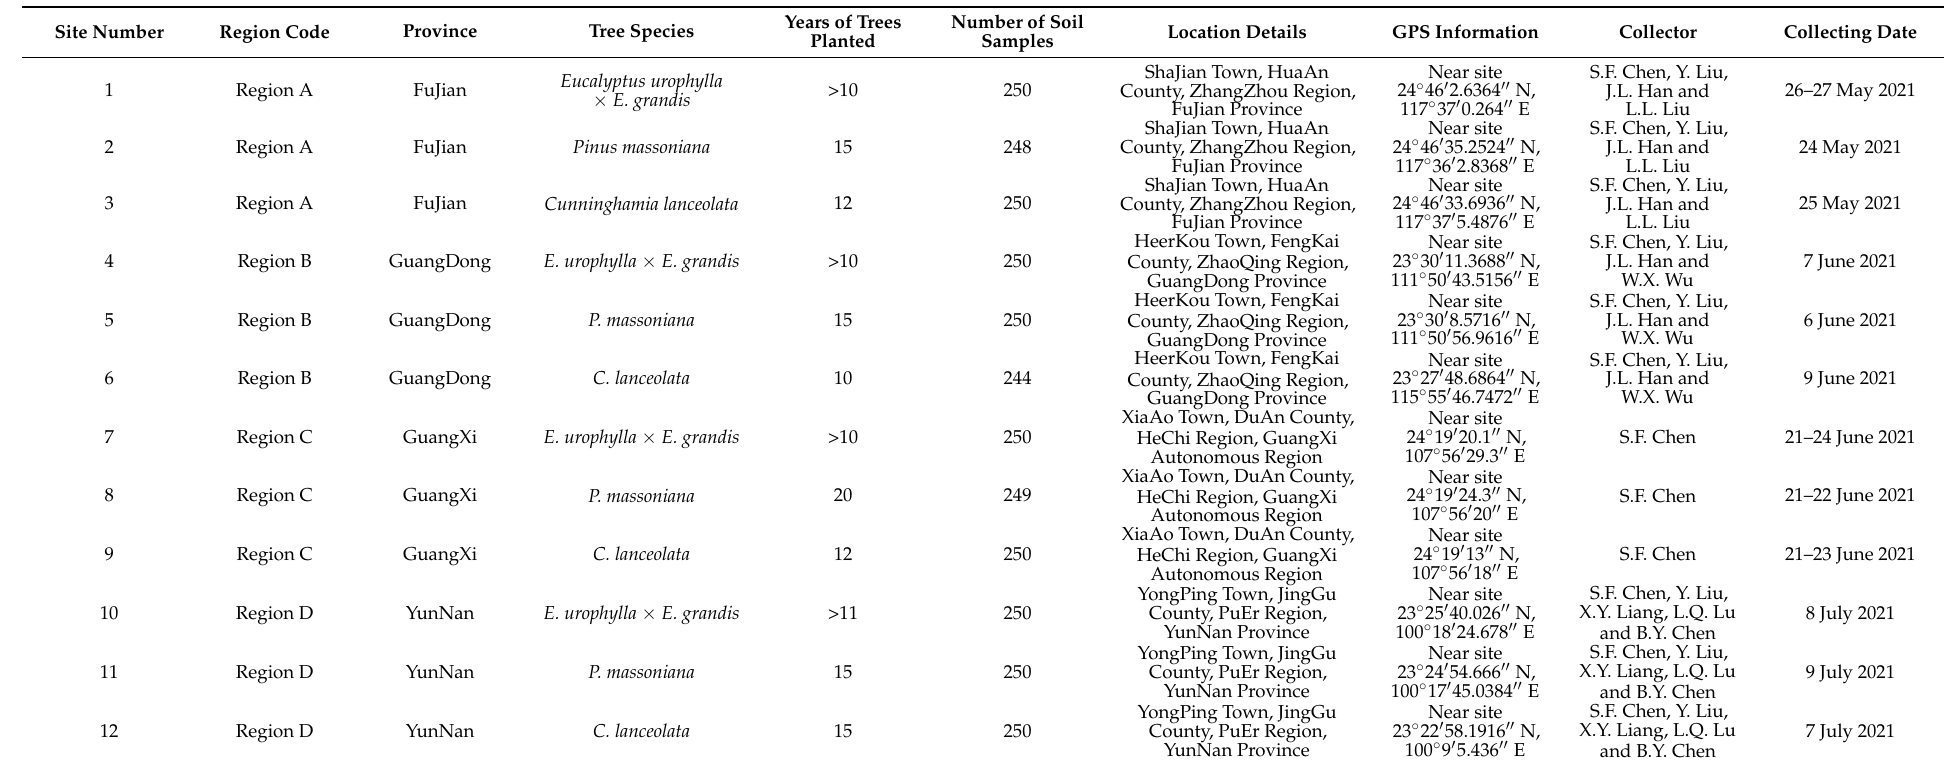
Table 1. Plantation tree species, location details, and collection information of soil samples collected from plantations of three tree species in four